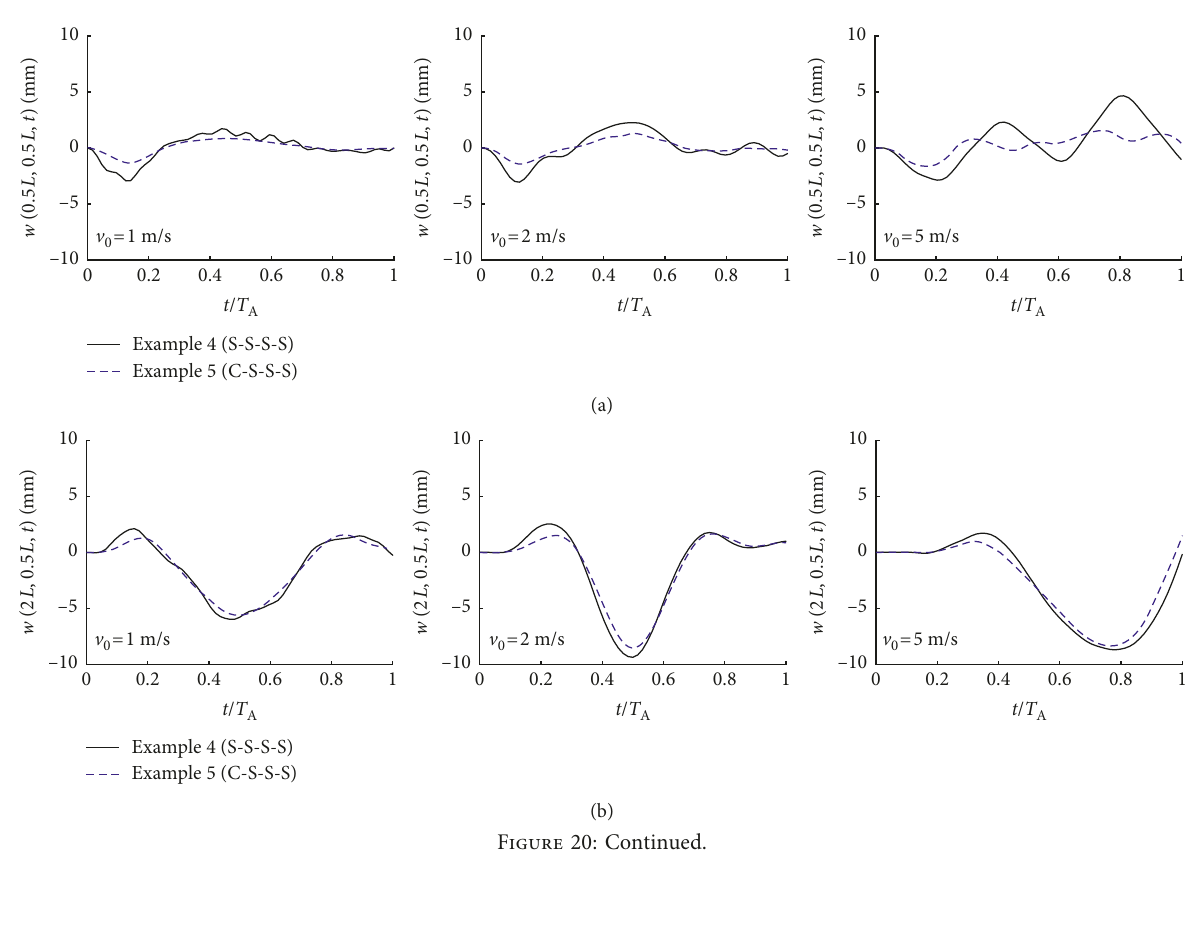
0.5 L , y 0.5 L , and (c) at (cid:31) (cid:31)